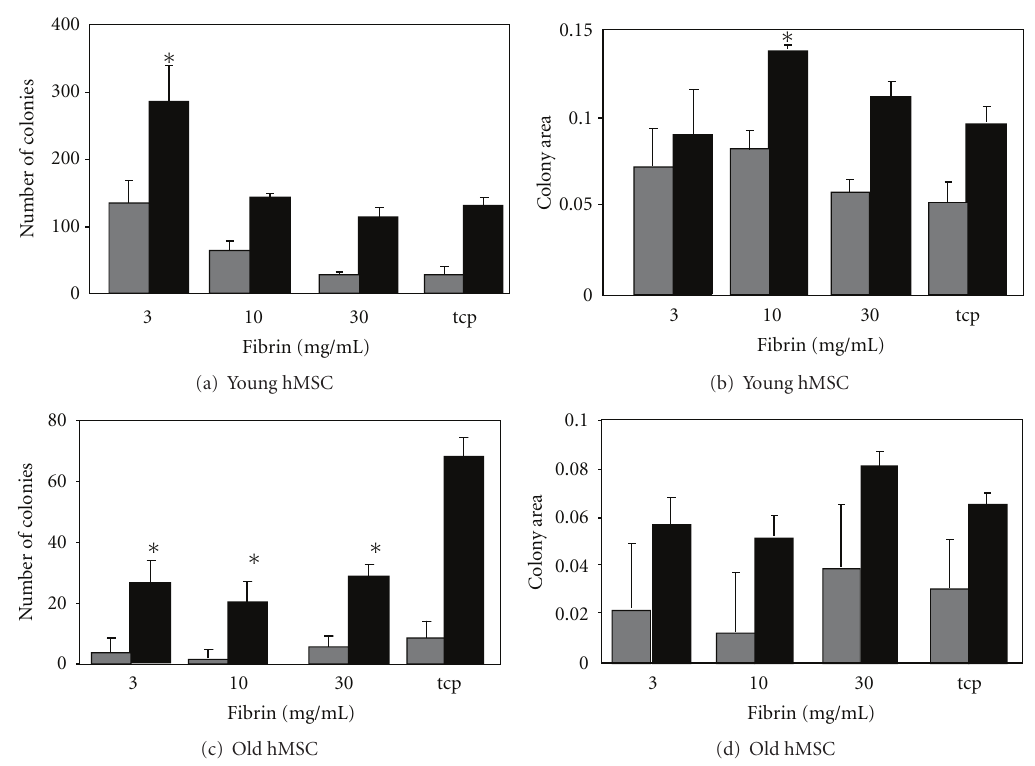
Figure 3: E ff ects of fibrin surfaces on young and old human MSC. Isolated MSC from young donors and aged donors were grown on fibrin gels for 7 days, and then 1000 cells were seeded into the CFU assays under osteogenic conditions. The number of ALP-positive colonies (grey) and total colony numbers (black) were calculated for young (a) and aged (c) MSC. Mean sizes of colonies were calculated for young (b) and aged (d) donor MSC. ∗ Denotes a statistically significant di ff erence from the other groups.